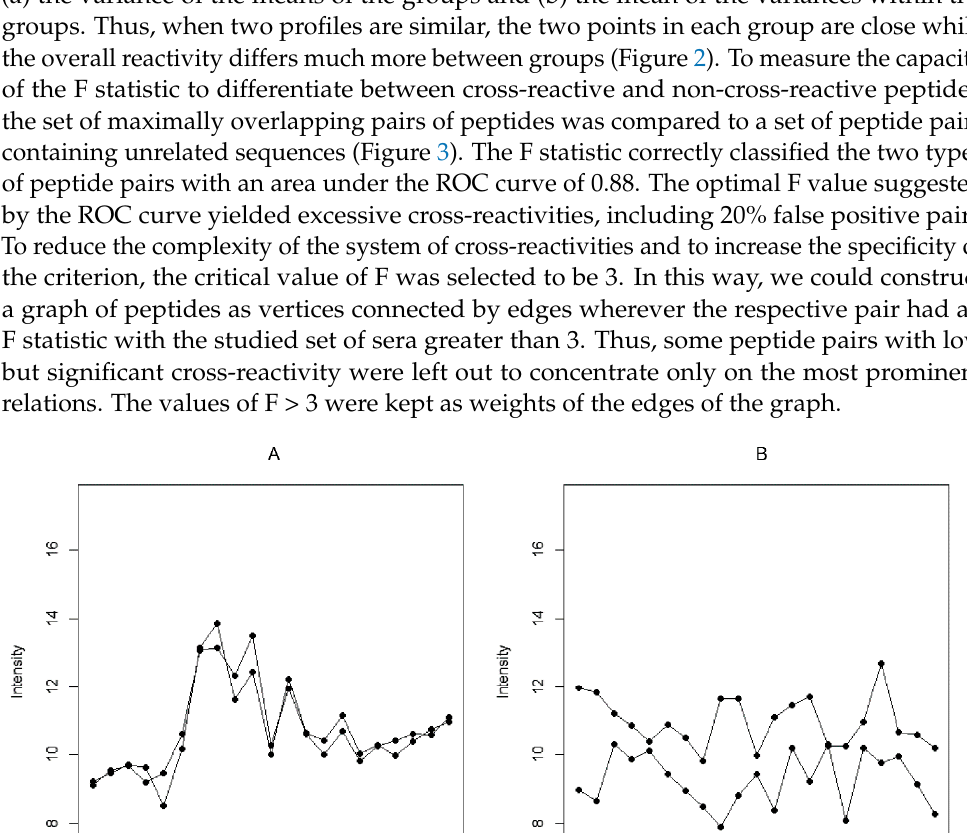
Figure 3. ( A ): ROC curve constructed on the basis of the F statistic of 4150 pairs of overlapping neighboring peptides from the studied proteins compared to a set of 10,000 pairs of dissimilar pep- tides selected to have a longest common subsequence of fewer than three residues. ( B ): Distributions of the logarithms of F statistic for dissimilar sequences (black) vs. overlapping sequences (red). The optimal tradeoff between sensitivity and specificity was found for F = 1 (1-specificity = 0.833, sensi- tivity = 0.769), but the F level of 3 was selected as a threshold (1-specificity = 0.977, sensitivity = 0.264) selecting the upper quartile of most cross-reactive pairs only.